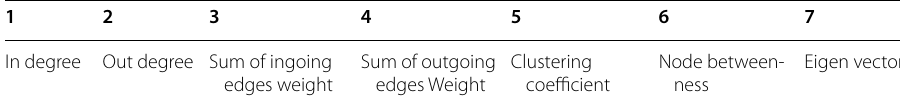
Table 2 Graph‑based features used for clustering